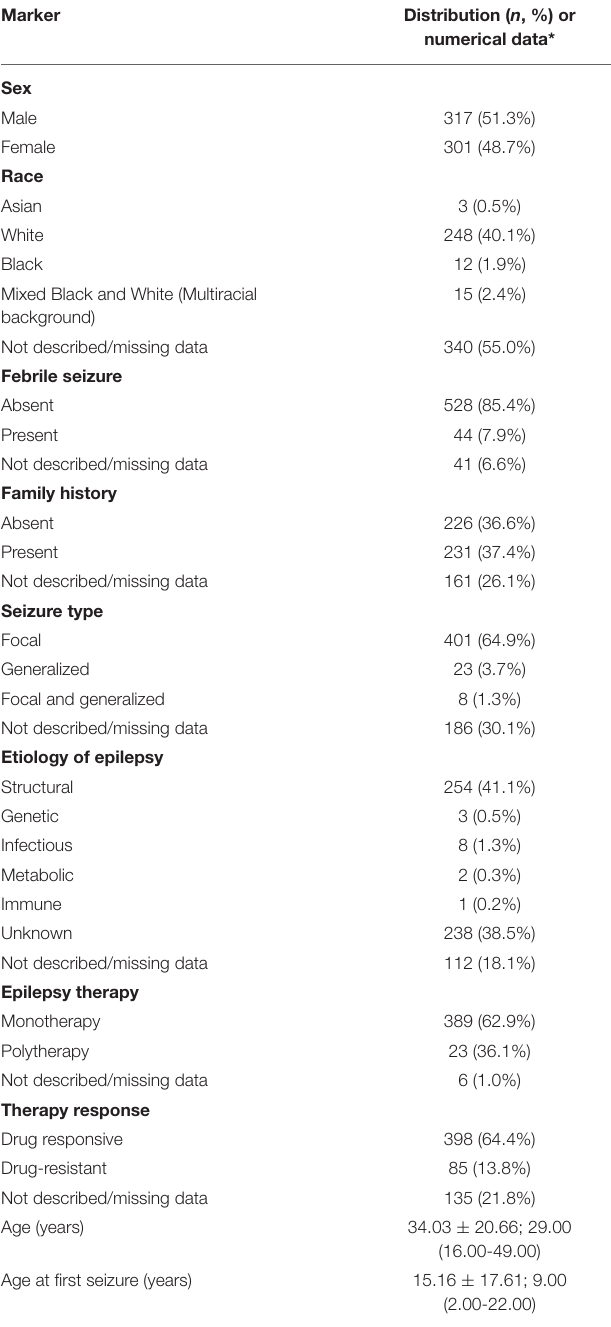
TABLE 2 | Epidemiological and clinical data of 618 patients with epilepsy from a Brazilian University Hospital in Southeast São Paulo between January 2010 and March 2021.